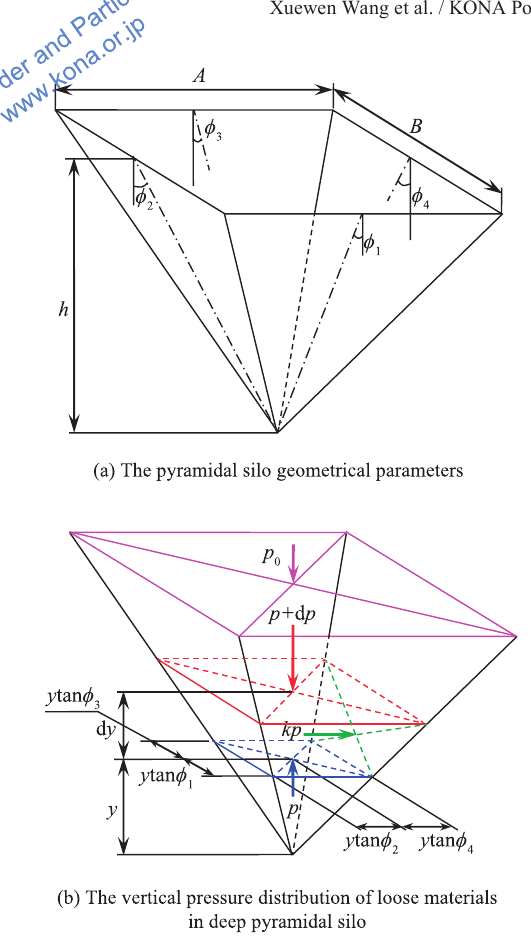
Fig. 2 The diagram of the vertical pressure distribution of loose materials in deep pyramidal